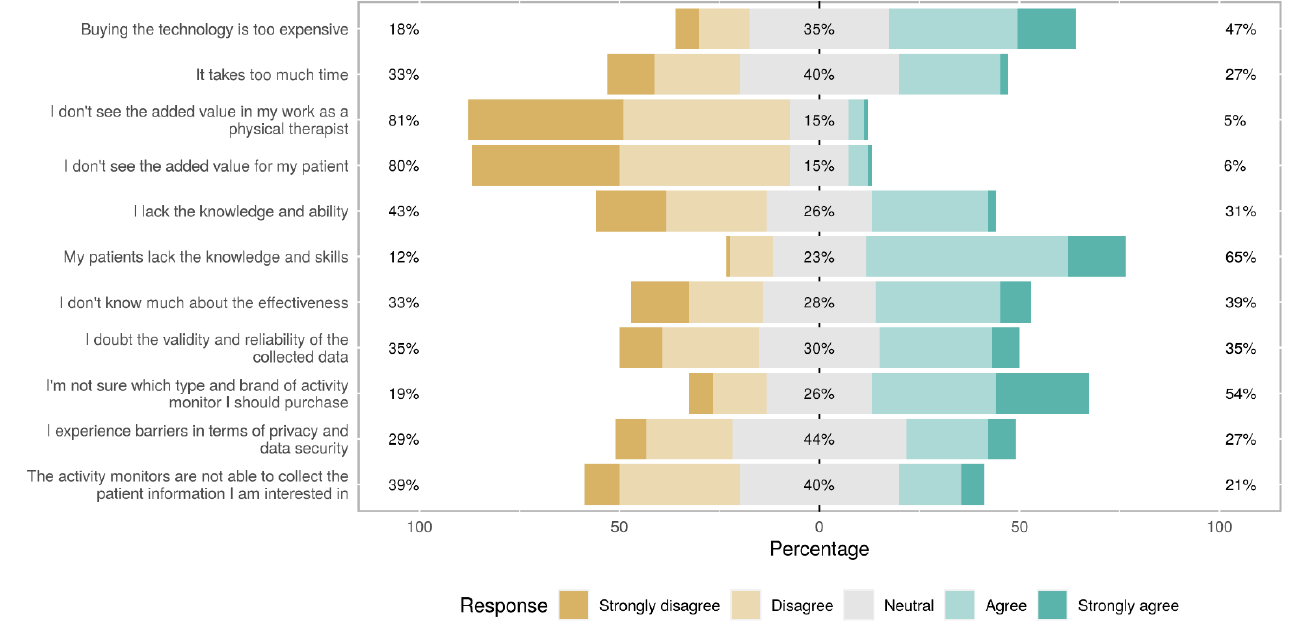
Figure 4. Barriers of using activity monitoring as a physical therapist.